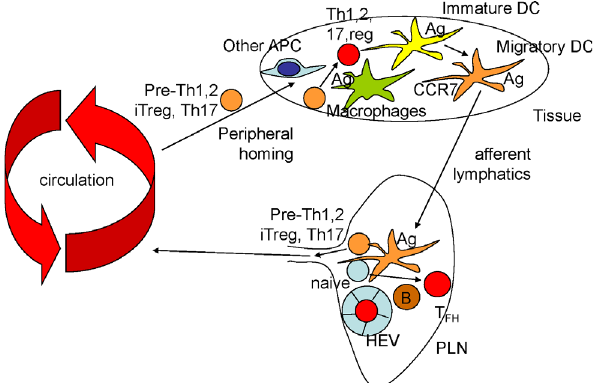
Figure 1. The second touch hypothesis. Naïve T cells (light blue) enter peripheral lymph nodes (PLN) through high endothelial venules (HEV), where they encounter antigen (Ag) presented by a migratory dendritic cell (DC) or by a PLN-resident B cell (brown). If signals induce Bcl6 and CXCR5, the T cells may enter the germinal center and become follicular helper T cells (TFH, red). Upon encountering antigen in the context of co-stimulatory molecules like CD80 and CD86, most T cells will express homing receptors, downregulate the sphingosine-1-phosphate receptor S1P1 and leave the PLN. These cells (orange) are only partially programmed and referred to as pre-Th1, pre-Th2, pre-Th17 and pre-iTreg. These cells circulate and reach various tissues, including the inflamed tissue from which the antigen came. There, they encounter DCs, macrophages and other antigen-presenting cells (APCs) such as endothelial cells. These cells present antigen in the context of different co-stimulatory molecules such as TNFSF members, and in the context of inflammatory cytokines found in the inflamed tissue. If the prevailing signal is IL-12, the T cell will commit to Th1, if IL-4, 5 and 13, to Th2, if IL-1, TGF- β , IL-6, IL-21, to Th17. If the cytokine environment is dominated by TGF- β , an M2 cytokine, the T cell